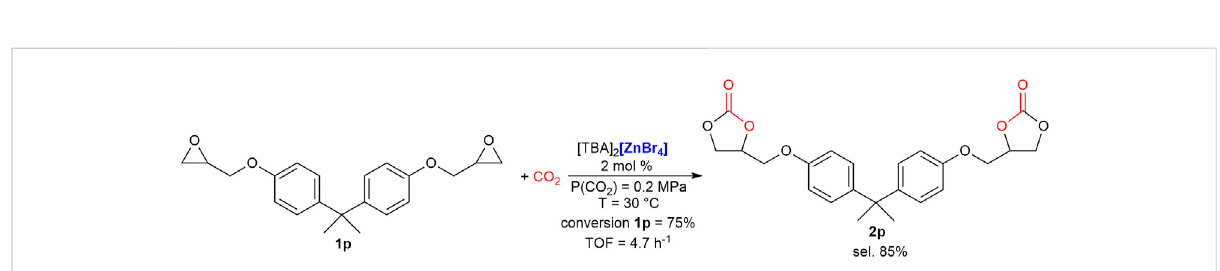
SCHEME 2 Selective synthesis of bis -carbonate of (bisphenol-A)diglycidyl ether (BADGE), 2p. Reaction conditions: epoxide, 1p , (340 mg, 1 mmol) dissolved in